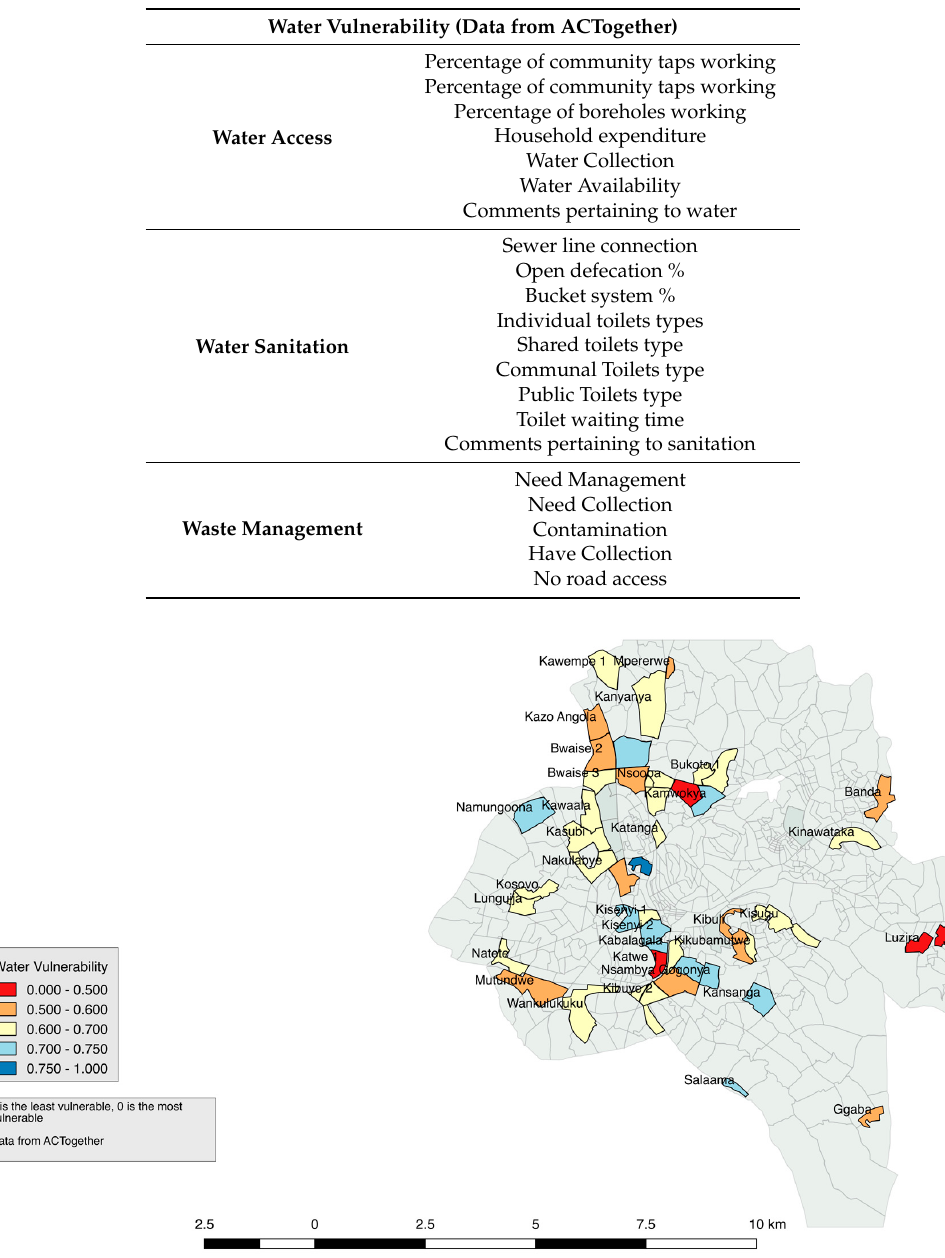
Figure 2. Water Vulnerability; Created with QGIS using variables in Table 1. 56 out of 57 slum communities have a water vulnerability score of under 0.75 (1 is least vulnerable and 0 is most vulnerable). The geographical units portrayed are Ugandan village boundaries.